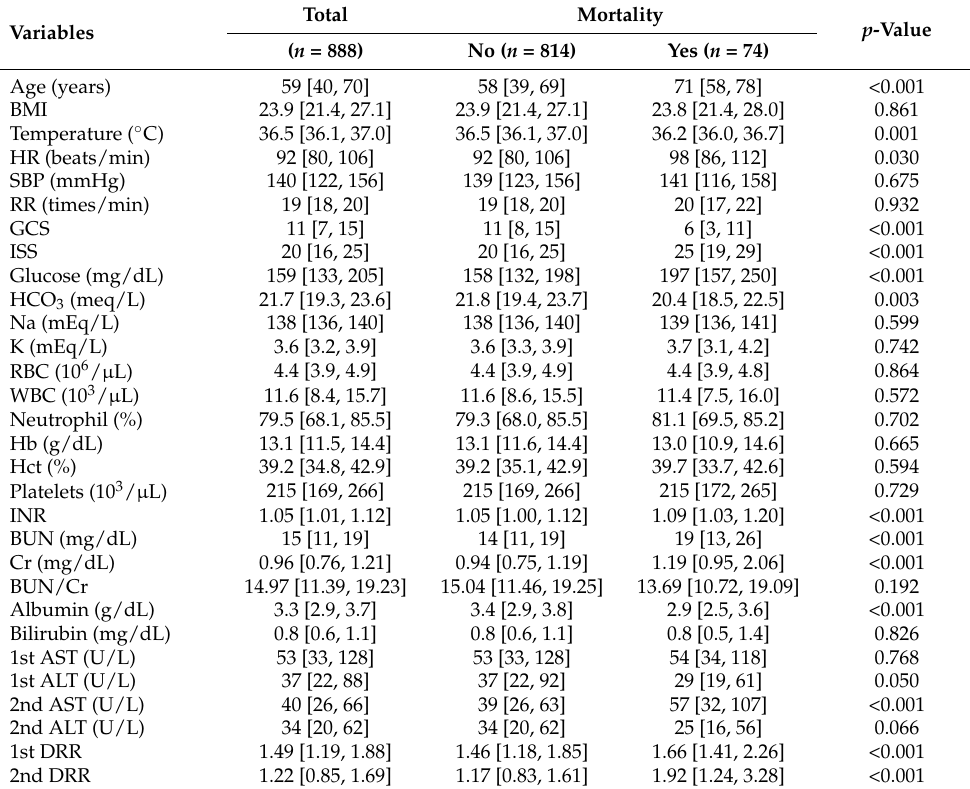
Table 2. Continuous variables of patient and injury characteristics of the death and survival adult trauma patients who were admitted into the intensive care